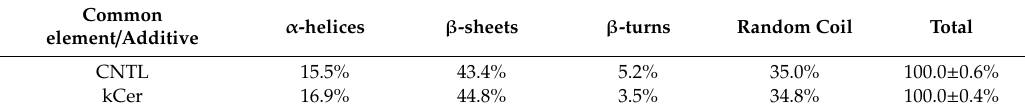
Table 2. Secondary structure of a1a2 (0.03 mg / mL) in the presence of kCer (1 µ M). Common α -helices β -sheets β -turns Random element / Additive